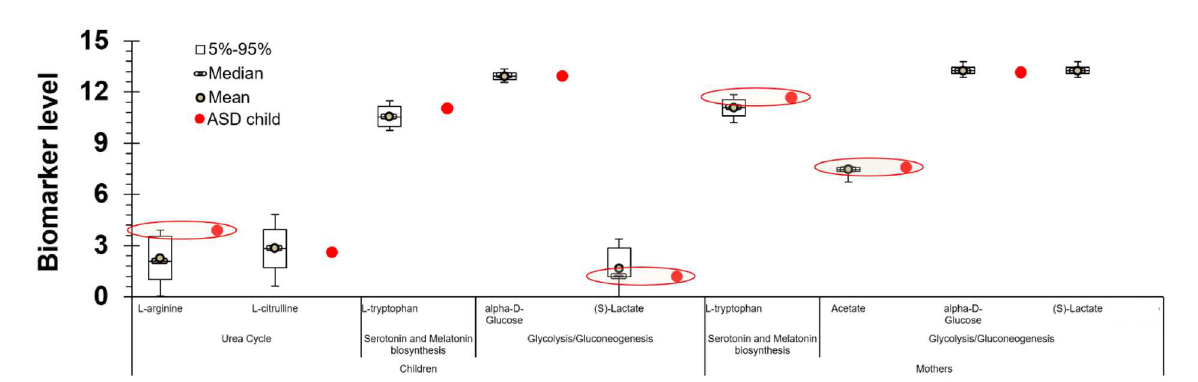
FIGURE3 Levels of specific metabolites, heavy metals and for the children with ASD participated in the PHIME cohort. L-arginine of the children diagnosed with ASD, L-tryptophan and acetate of their mothers were above the 95th percentile (S)-Lactate of the children was below the 5th percentile. As and Hg levels in children blood diagnosed with ASD were above the 95th